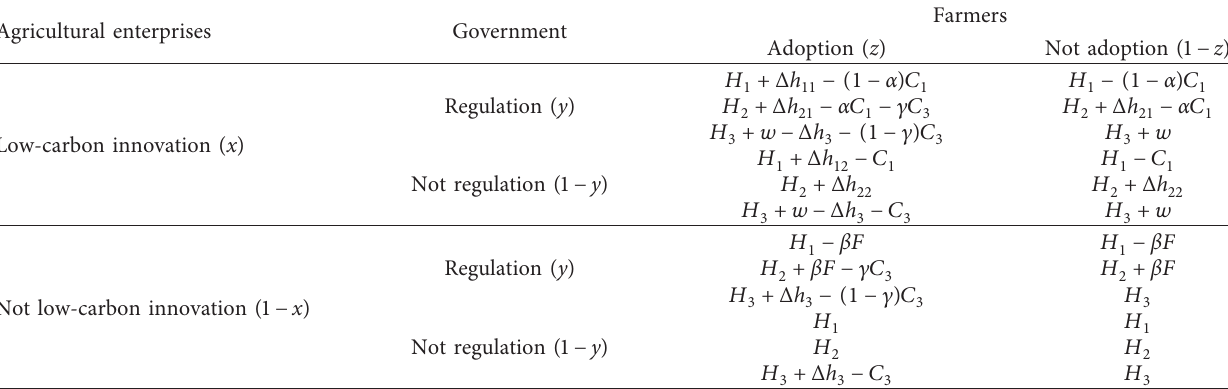
Table 2: The payoff matrix among agricultural enterprises, government, and